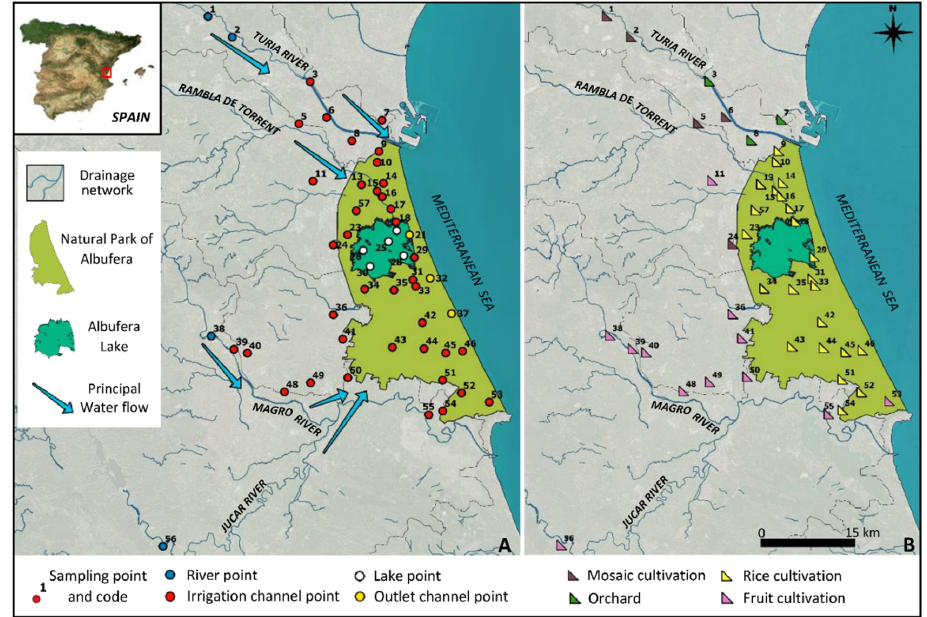
Figure 1. Study area with the principal river networks, the limit of the Natural Park of Albufera and the area of Albufera Lake. ( A ) Sampling points classified according to their corresponding aquatic habitats and arrows showing the principal water flow to the natural park. ( B ) Sampling points classified according to the agricultural activity carried out in their vicinity. Base image: OrtoPNOA 2018 CC-BY 4.0